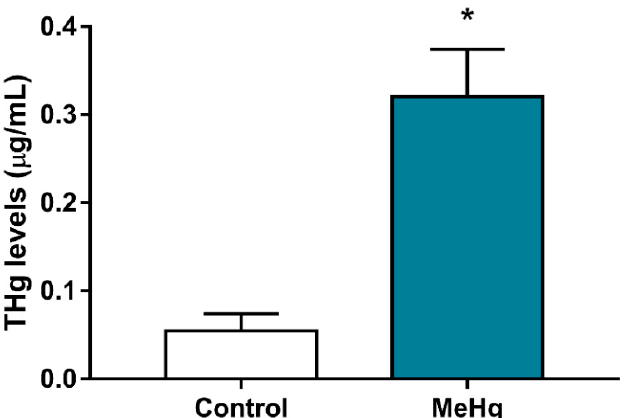
Figure 1. Exposure to MeHg during the gestation and lactation periods increases THg in the offspring (samples collected 21 days after 42 days of dosing). Results are expressed as the mean ± standard error of the mean ( µ g/mL). ( n = 7–8 animals per group). * p < 0.05, Student’s t